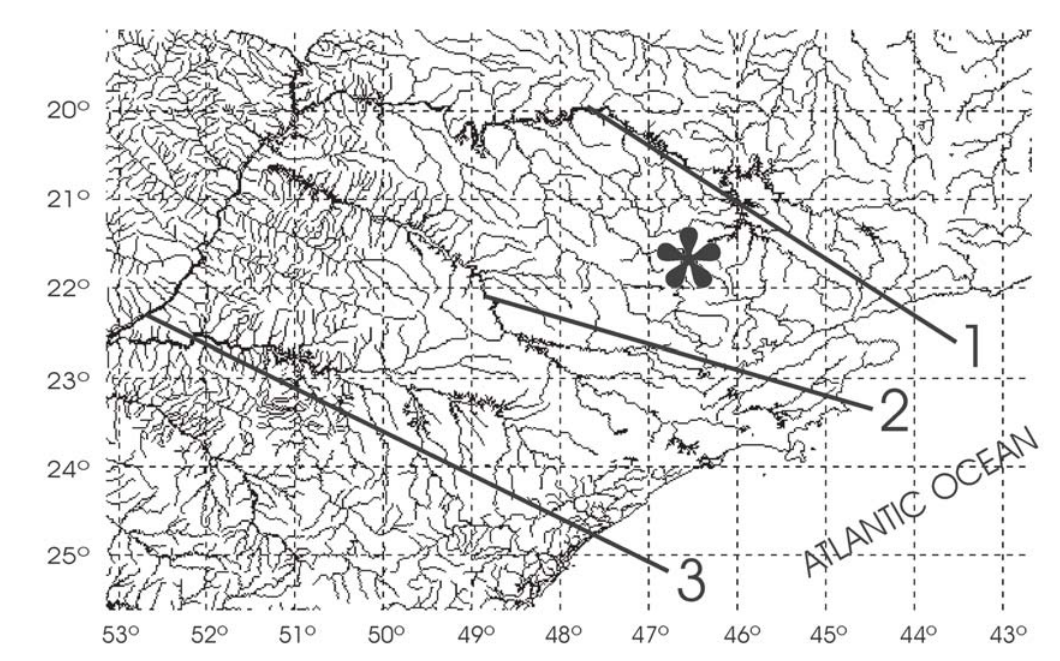
Fig. 9. Map of Southeastern South America with the geographic distribution of Trichomycterus maracaya plotted; 1, rio Grande; 2, rio Tietê; 3 , rio